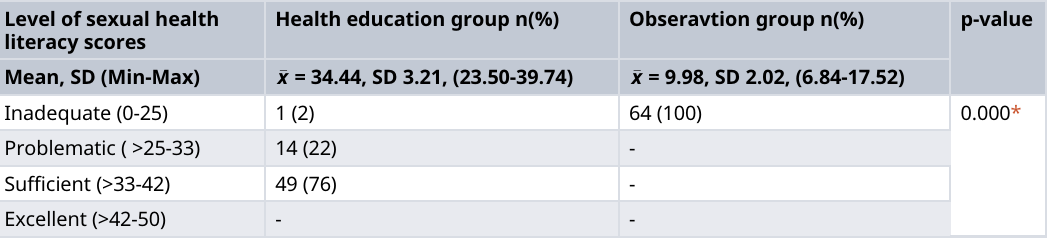
Table 2. Level of sexual health literacy scores among secondary school female students of health education and observation groups. Level of sexual health literacy scores